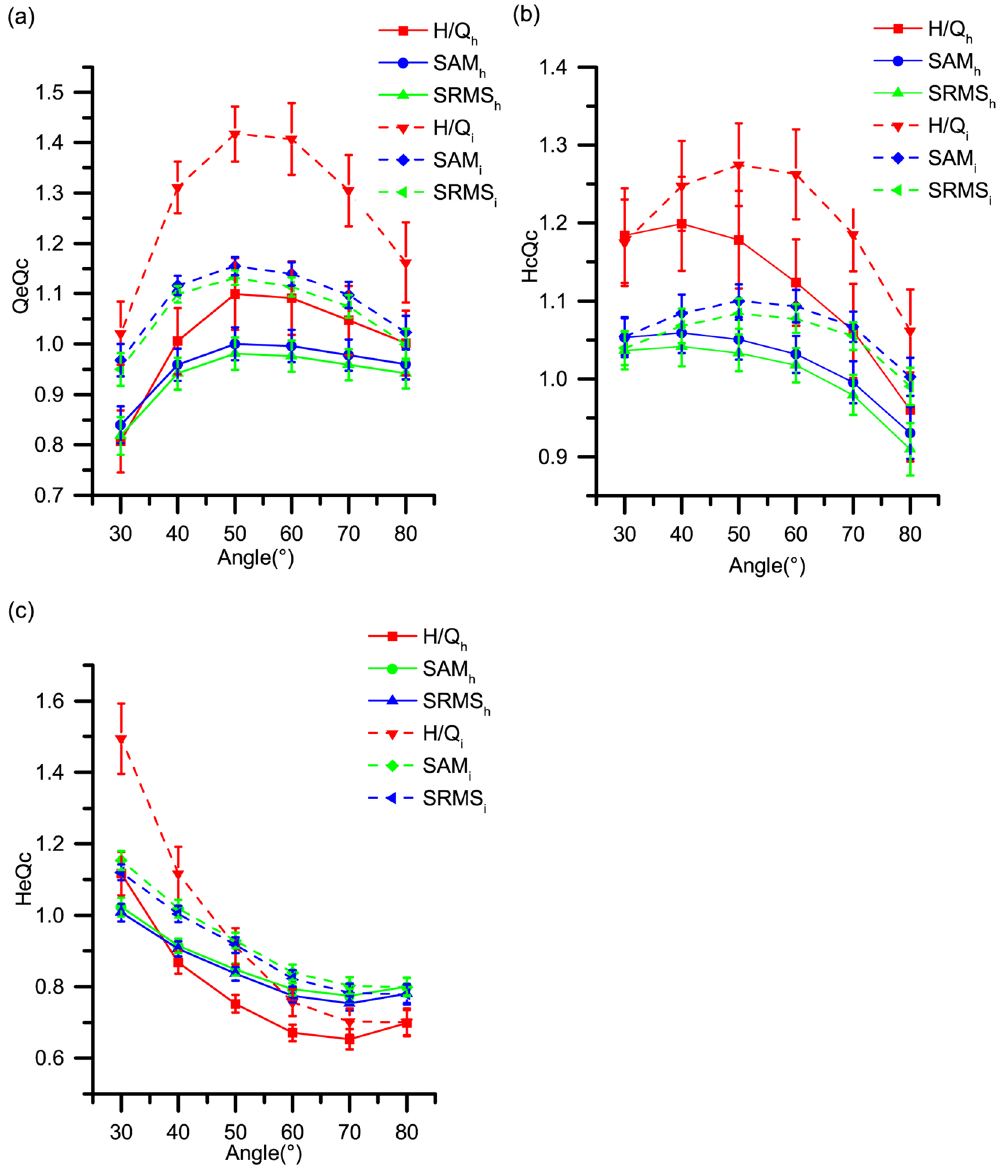
Figure 2. Mean values and standard error (s.e.m.) plot of H/Q ratio, SAM and SRMS indices. ( a ) The Qe/Qc, SAM-QeQc and SRMS-QeQc indices; ( b ) the Hc/Qc, SAM-HcQc and SRMS-HcQc indices; ( c ) the He/Qc, SAM-HeQc and SRMS-HeQc indices. SAM, single-to-arithmetic-mean form indices; SRMS, single-to-root- mean-square form indices; h, healthy limb (in solid lines); d, ACLD limb (in dashed